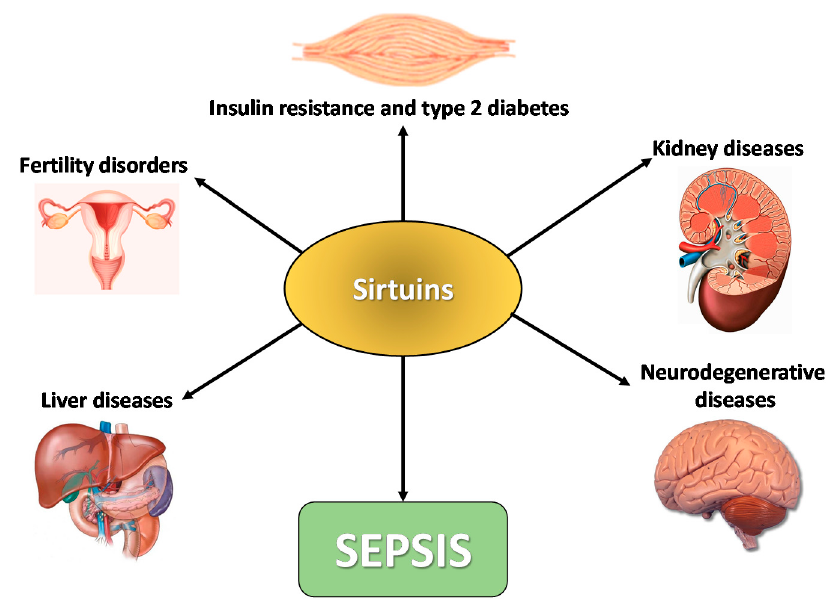
Figure 4. The enzymatic effect of SIRTs on selected organs. Modification according to Giblin et al. [103].